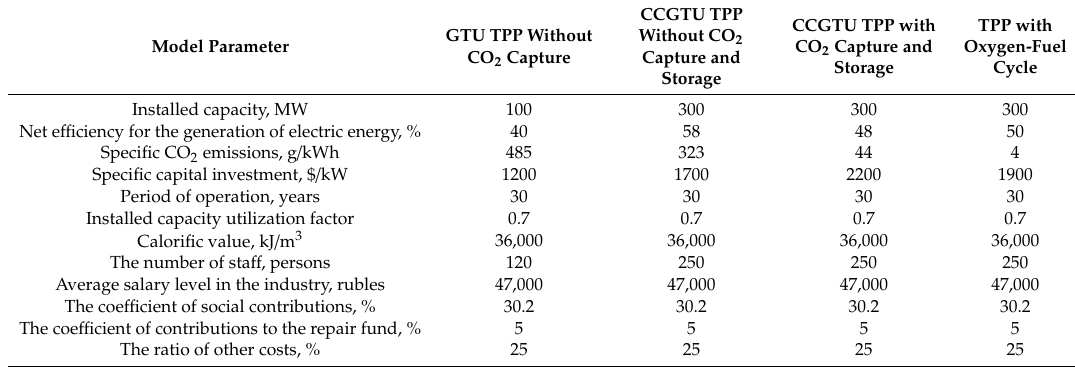
Table 3. The calculated parameters of the model for determining the cost of electricity at di ff erent costs of fossil fuels and the availability of quotas for greenhouse gas emissions.